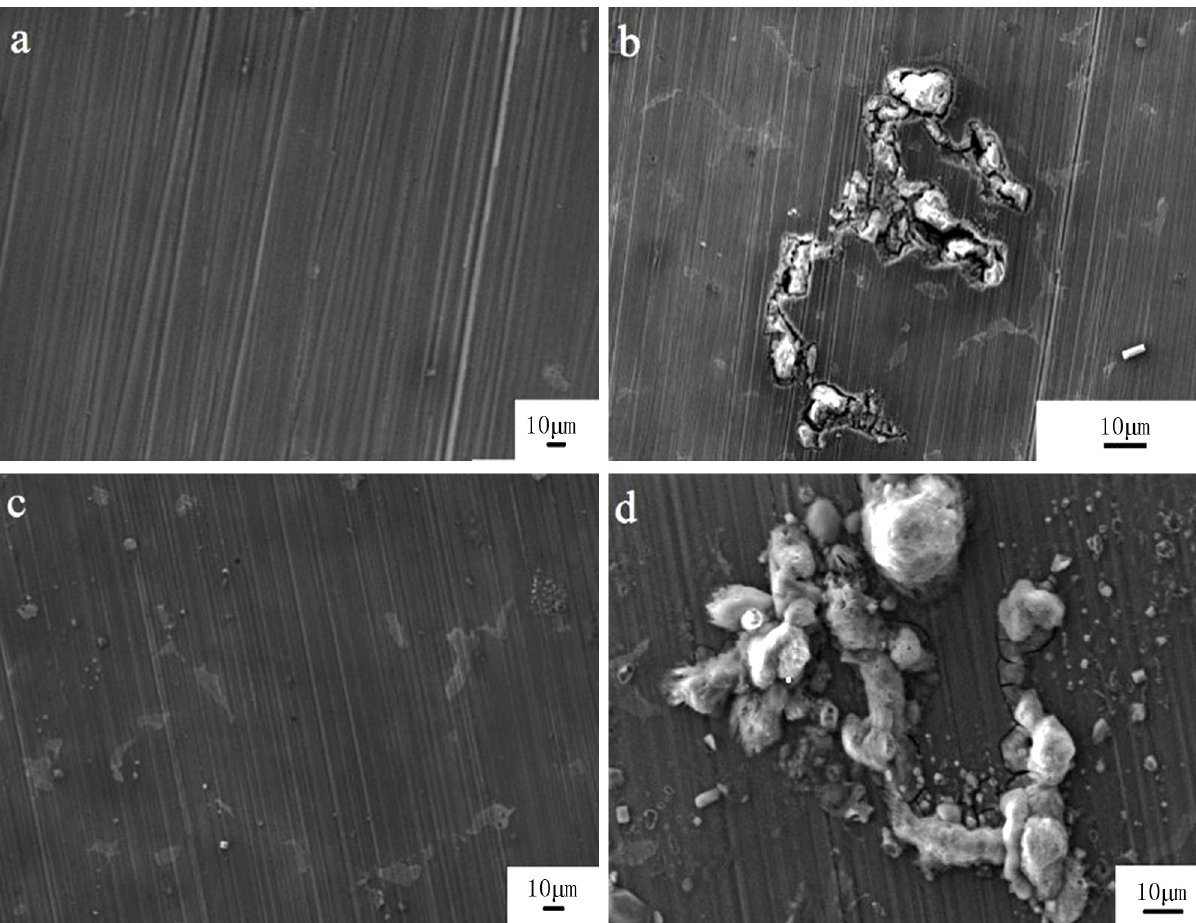
Fig 8. SEM images of AZ91D alloy after different exposure time. a: 1 h, at the central zone; b: 1 h, near the TPB zone; c: 6 h, at the central zone; d: 6 h, near the TPB zone.